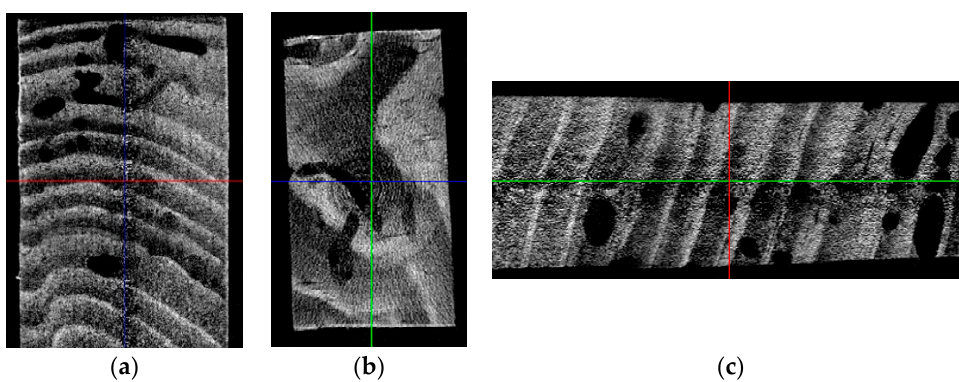
Figure 3. Two-dimensional images of the reconstructed object (samples approximately 40 × 20 × 10 mm 3 ): ( a ) xy: coronal plane; ( b ) xz: sagittal plane; ( c ) yz: trans axial plane.